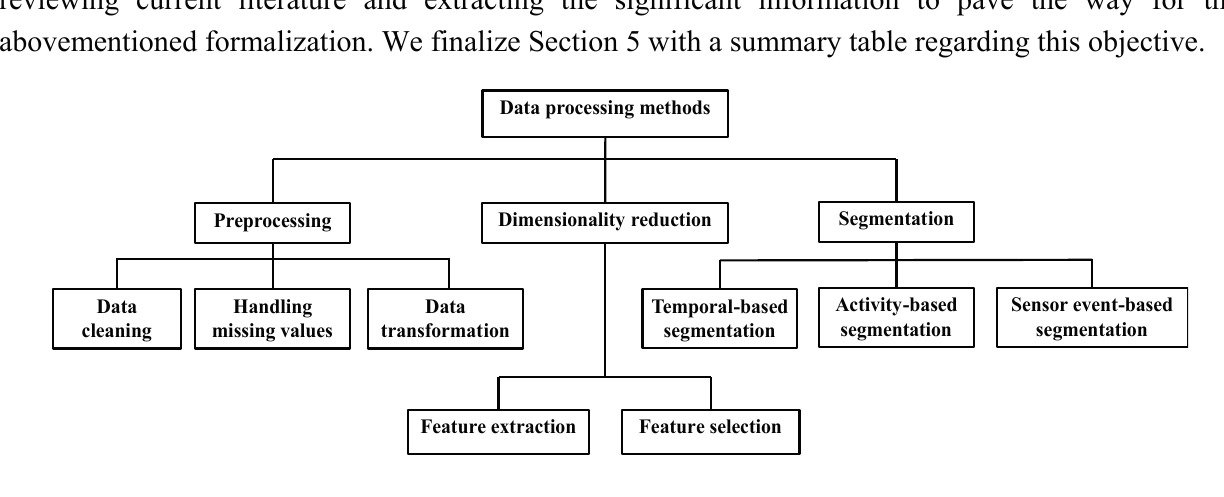
Figure 4. Sensor data processing methods